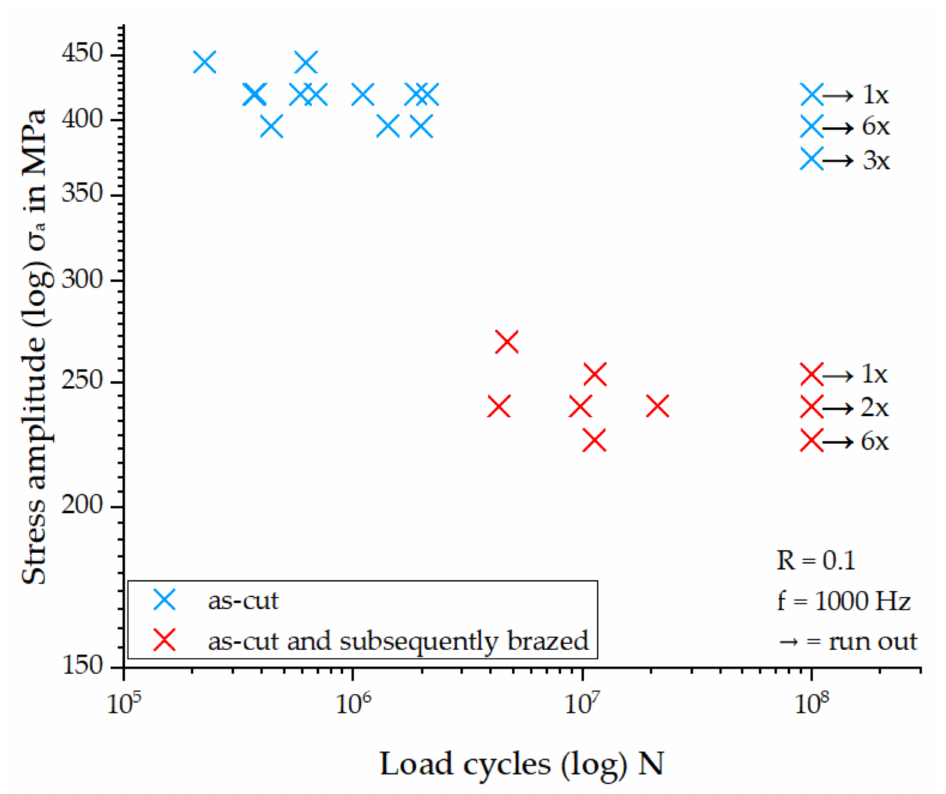
Figure 7. Results of the fatigue tests of as-cut and brazed specimens. Fatigued samples were subjected to fracture surface analysis by SEM. Figures 8 and 9 show fracture surfaces representative for samples in the as-cut and brazed condition, respectively. For the as-cut specimen, it can be seen that the fatigue crack initiated at the burr and propagated through the material. In the case of the brazed specimens, on the other hand, no specimen failed in relation to the laser-cut edge. Instead, process-related inhomogeneities in the filler metal always led to crack initiation. The brazed connection between base material and LR never failed.